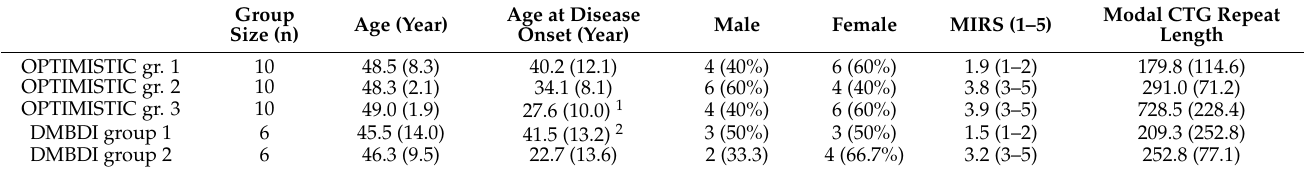
Table 1. DM1 patient characteristics in the OPTIMISTIC and DMBDI cohorts.